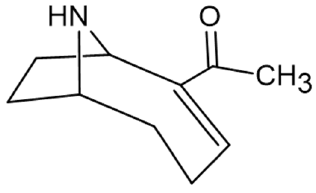
Figure 3. Anatoxin-a. Figure 3.